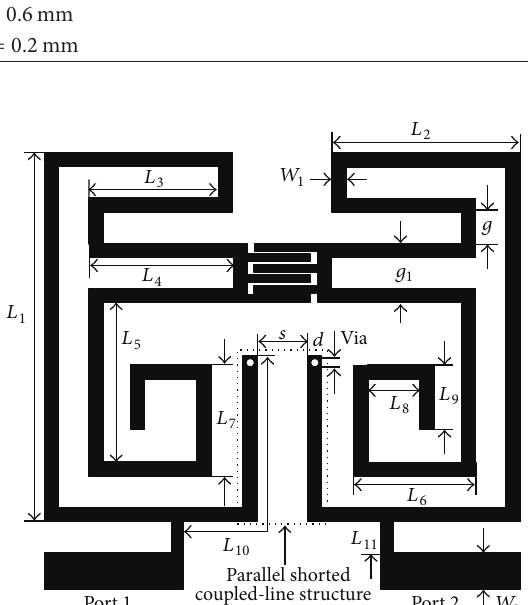
Figure 1: Schematic of the proposed miniaturized bandpass filter.